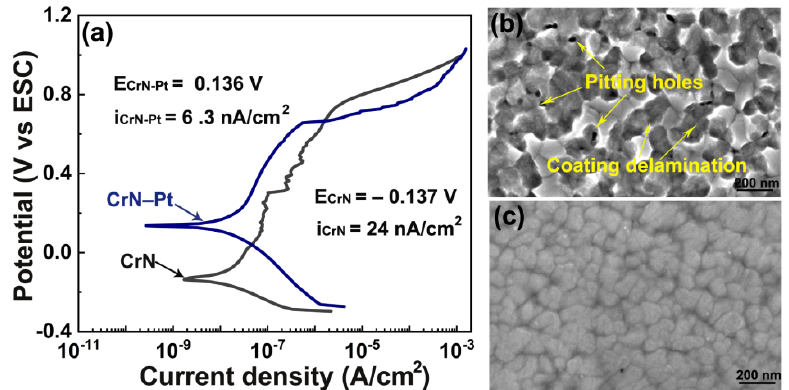
Figure 6. ( a ) polarization curves and corrosion data of all coatings, ( b ) corrosion image of the CrN coating, ( c ) corrosion image of the CrN – Pt coating.